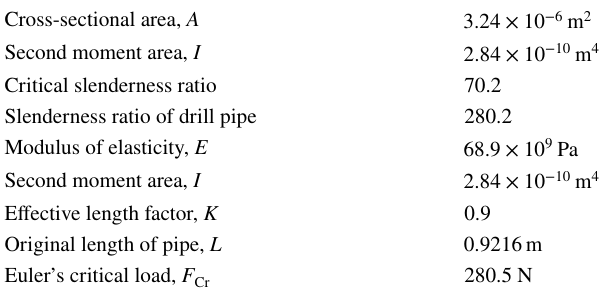
Table 2 Results on slenderness and load calculations Cross-sectional area,